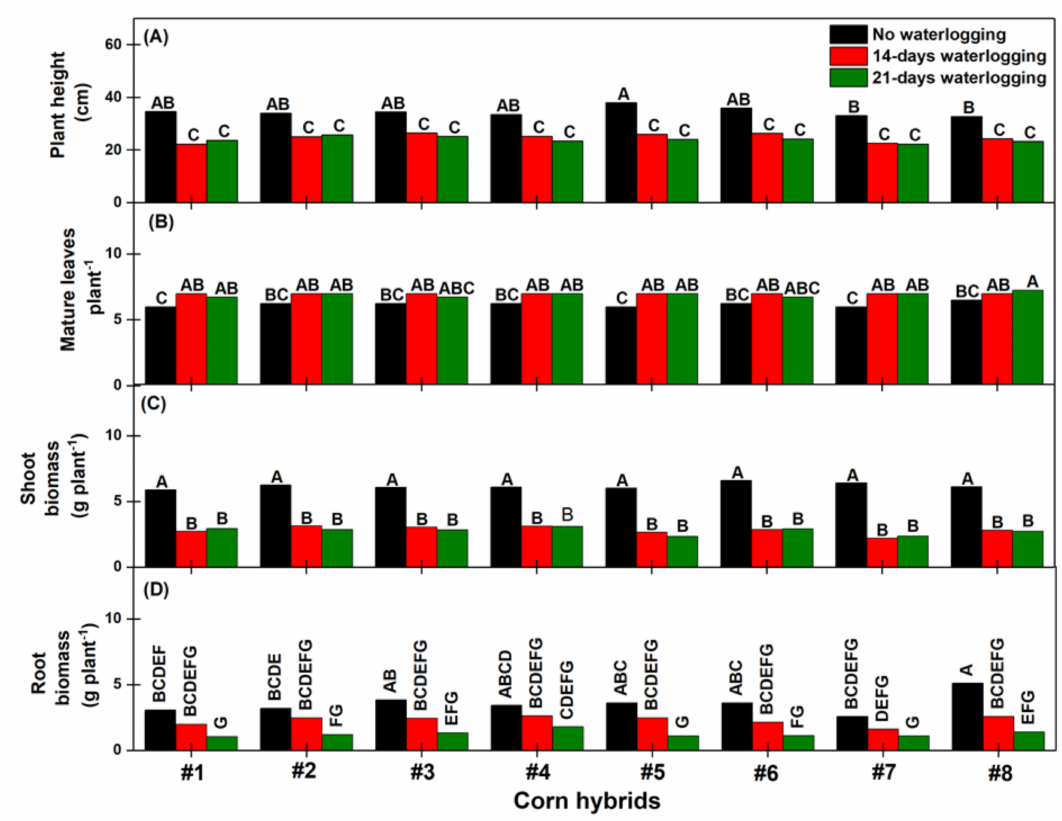
Figure 10. Plant height ( A ), number of mature leaves ( B ), shoot ( C ), and root ( D ) biomass as affected by the waterlogging duration and corn hybrids. Same letters on bars indicate means do not differ significantly ( p < 0.10) based on Fisher’s least significant difference